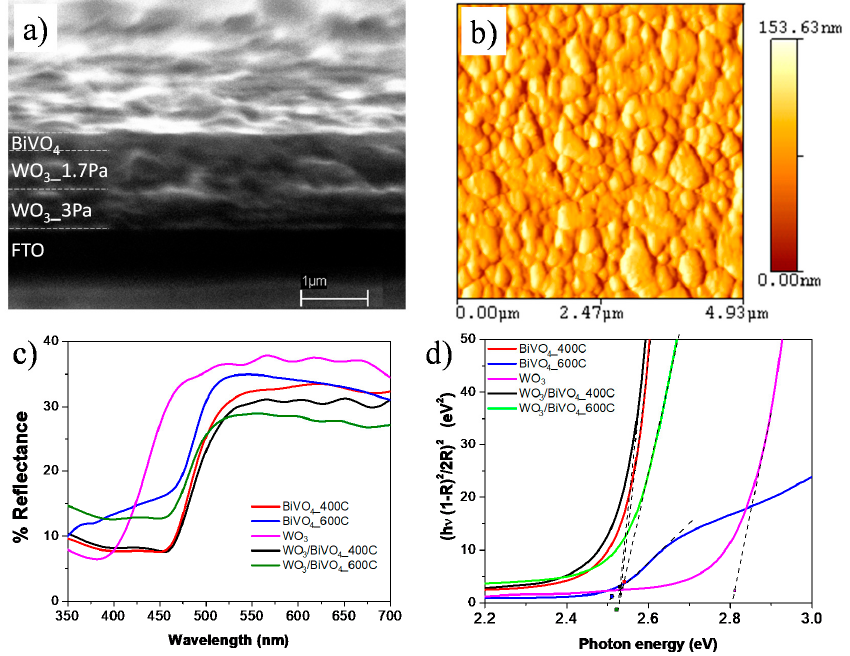
Figure 1. ( a ) Cross section SEM and ( b ) top view AFM images of WO 3 /BiVO 4 _400 °C; ( c ) UV-vis reflectance spectra and ( d ) Tauc plots for direct band gap of the investigated samples.